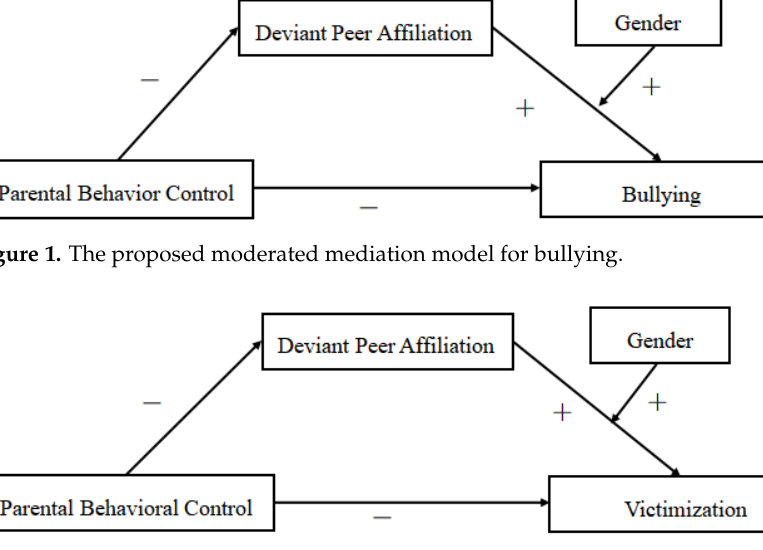
Figure 2. The proposed moderated mediation model for victimization.